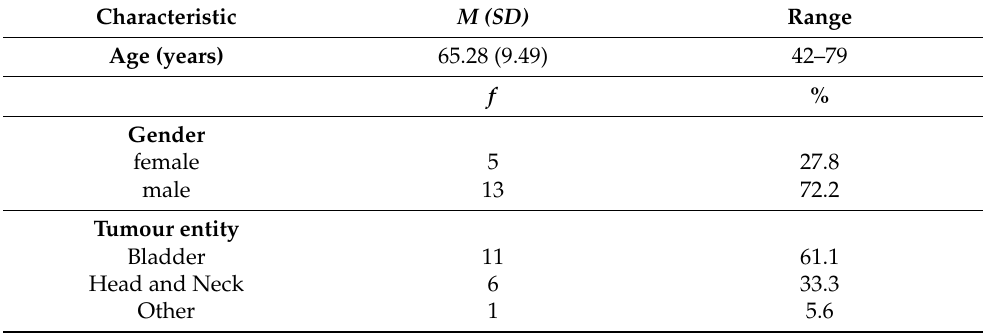
Table 1. Participant characteristics of the UPIM-Check German version psychometric pilot